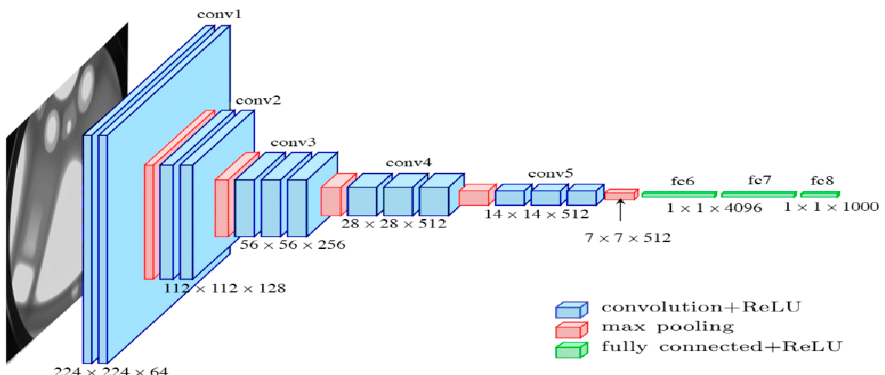
Figure 6. VGGNet Figure 6. VGGNet architecture.